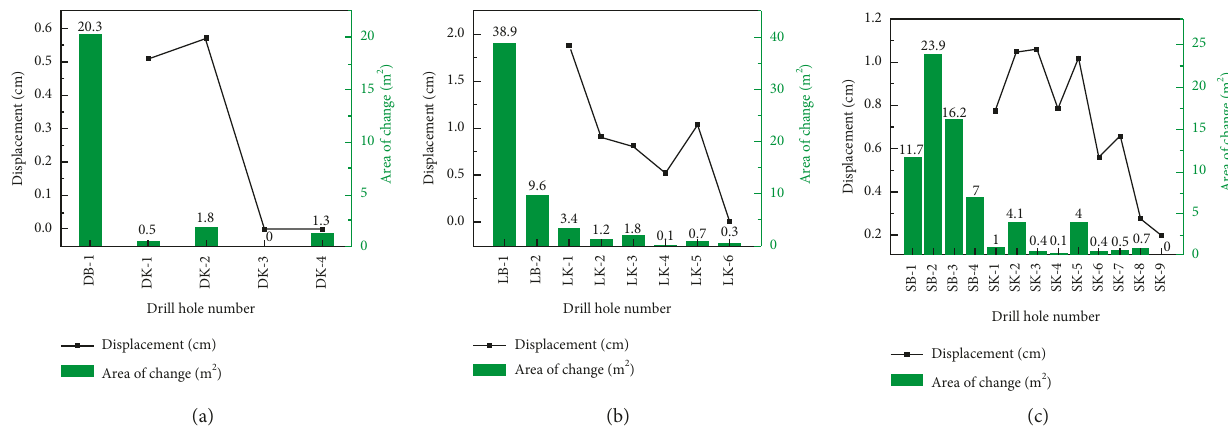
Figure 9: Change of drilling displacement and area after blasting. (a) Single-hole blasting model. (b) Double-hole blasting model. (c) Four- hole blasting